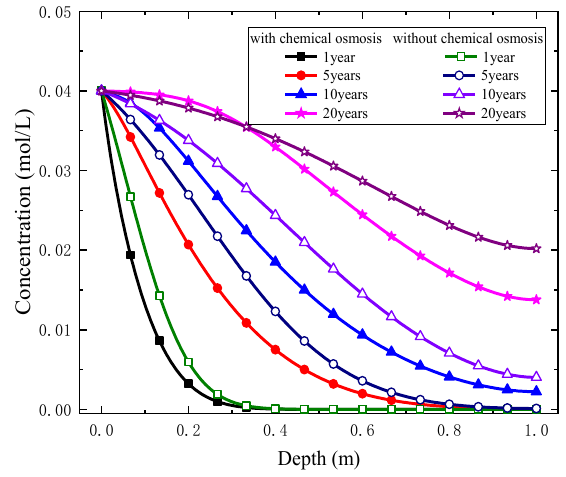
Figure 2: Distribution of solute concentration with depth.